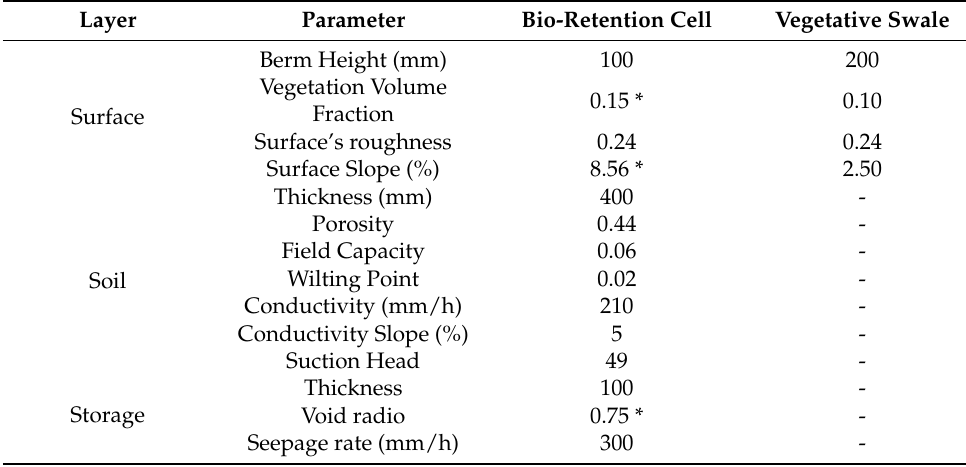
Table 3. Parameters of bio-retention cell and vegetative swale.